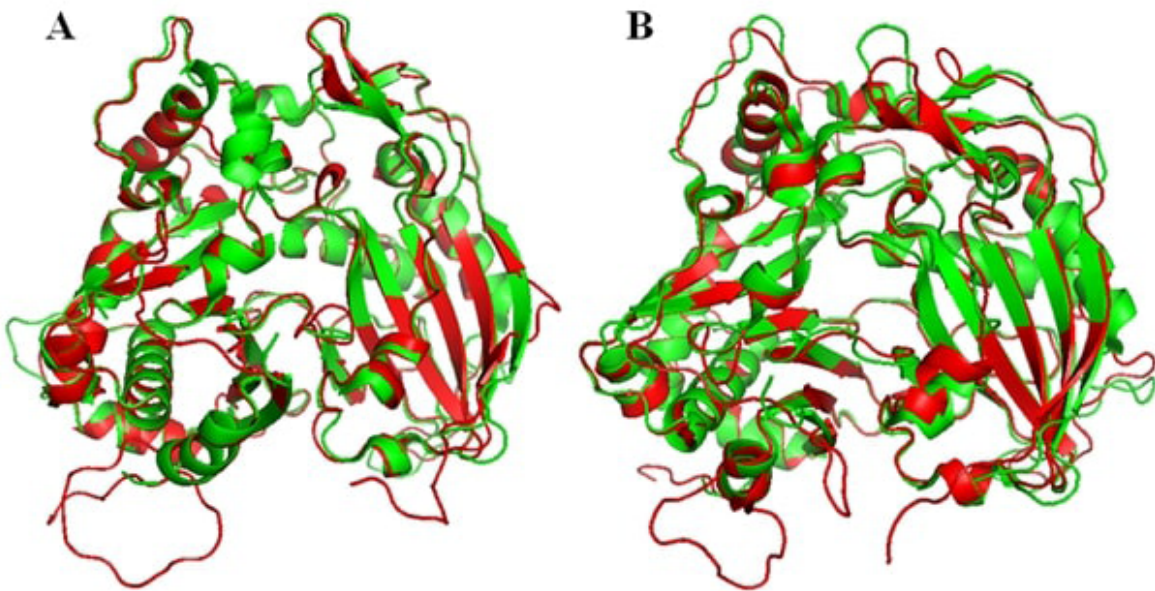
Figure 4 - Cartoon representation for the superimposition between the 3-D Petunia hybrida structures and Panicum virgatum template: (A) PhBPBT sequence; (B) PhCFAT sequence. The template is represented in green, BPBT and CFAT in